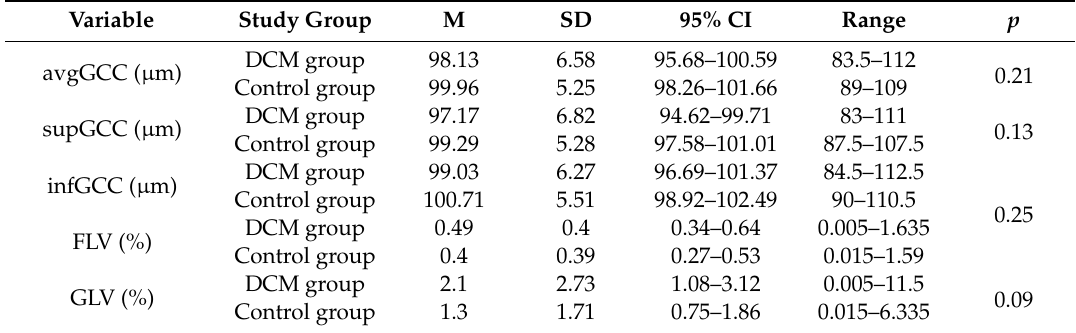
Table 2. Descriptive statistics for GCC ( µ m) at selected anatomical locations (patients with DCM vs. controls).